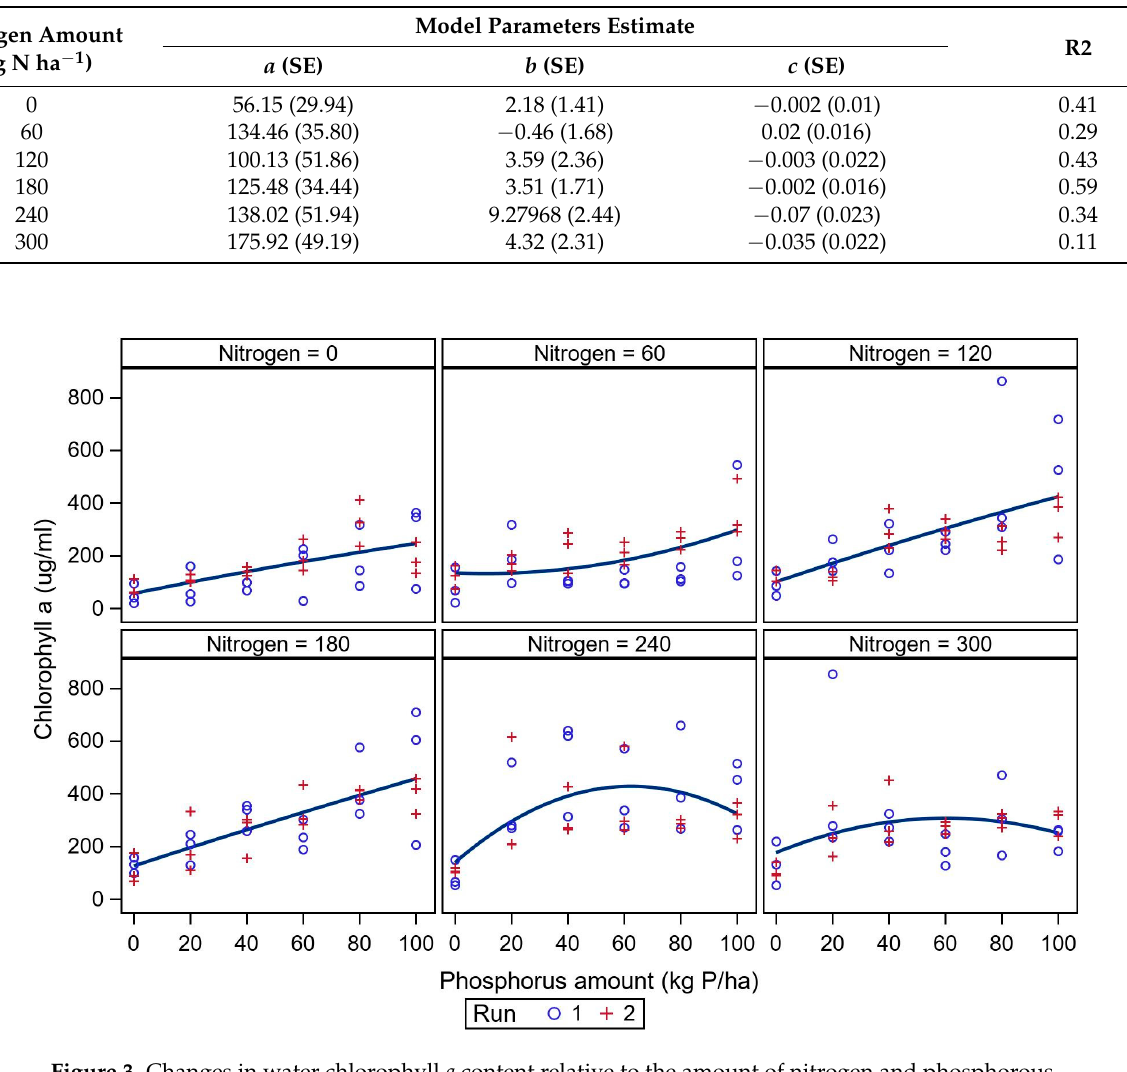
Table 3. Parameters of the model fitted to the response of chlorophyll a content to phosphorous at different nitrogen levels. The fitted model was y = a + bP + cP 2 , where y is chlorophyll a content ( µ g/mL), P is the amount of phosphorous, a is the model intercept and b and c are the coefficients of the second-order polynomial model.